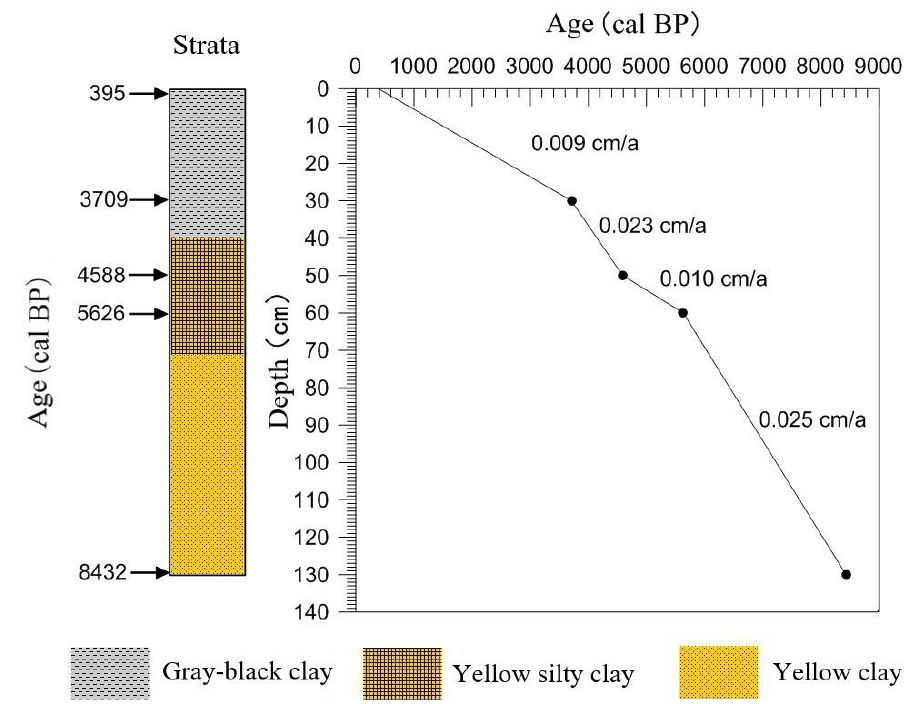
Figure 3. The lithologic characteristics, age and deposition rate of the GX2